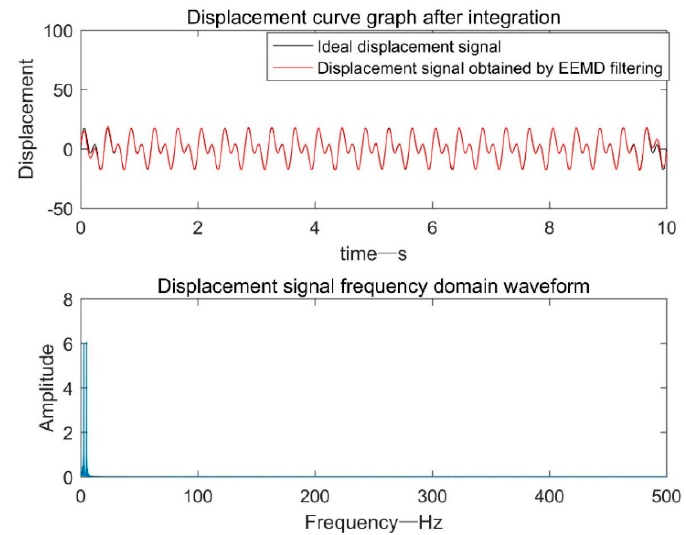
Figure 9. Displacement signal after EEMD adaptive filtering.